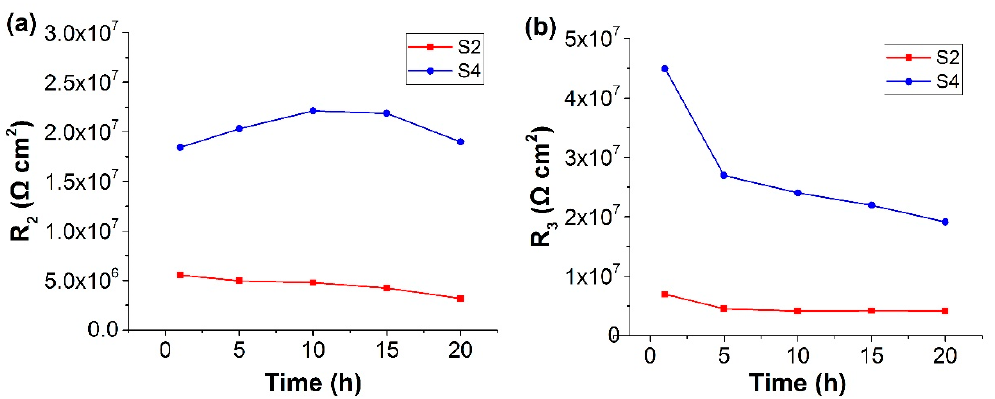
Figure 9. Change of fitting parameters: ( a ) coating resistance R 2 and ( b ) intermediate layer resistance R 3 of S2 and S4 along the exposure time (up to 20 h of immersion) in 0.1 wt.% NaCl solutions.